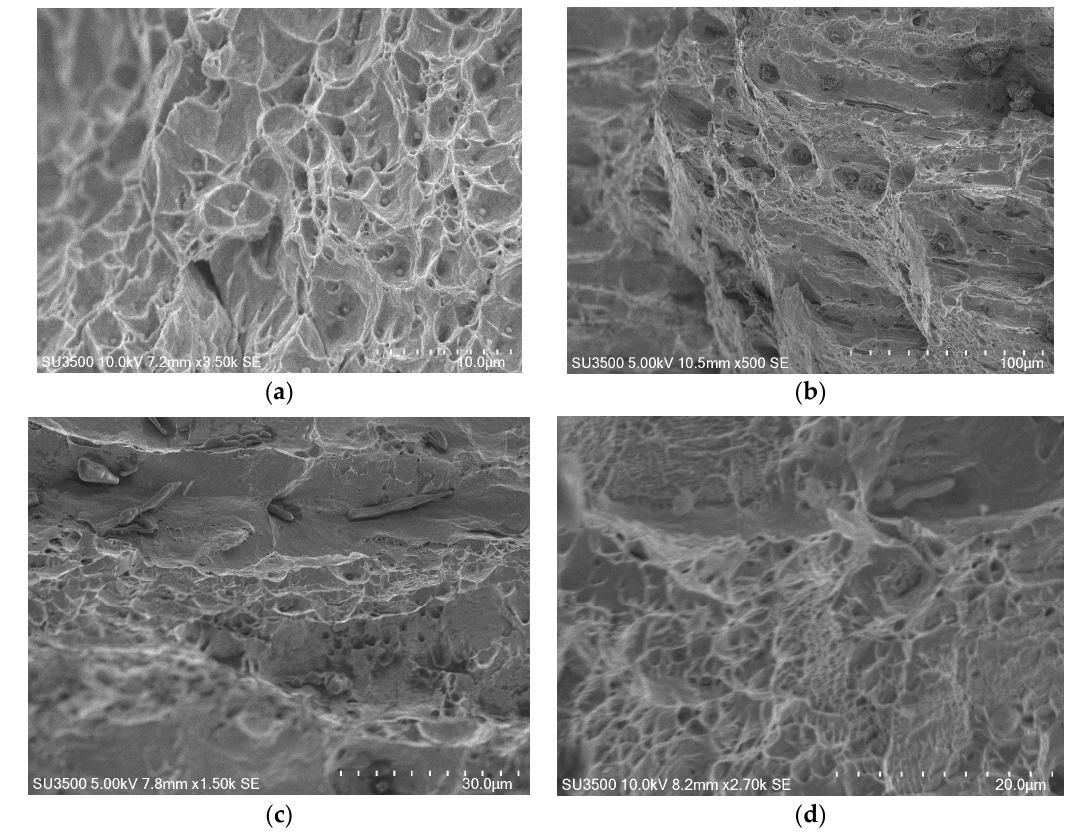
Figure 13. Scanning electron microscope of impact fracture surface. ( a ) fusion zone accelerating voltage = 10,000 Volt; magnification = 3500; working distance = 7210 µm; ( b ) high temperature heat affected zone accelerating voltage = 5000 volts; magnification = 500; working distance = 1030 µm; ( c ) low temperature heat affected zone accelerating voltage = 5000 volts; magnification = 1500; working distance = 7820 µm; ( d ) unaffected base metal accelerating voltage = 10,000 volts; magnification = 2700; working distance = 8190 µm.